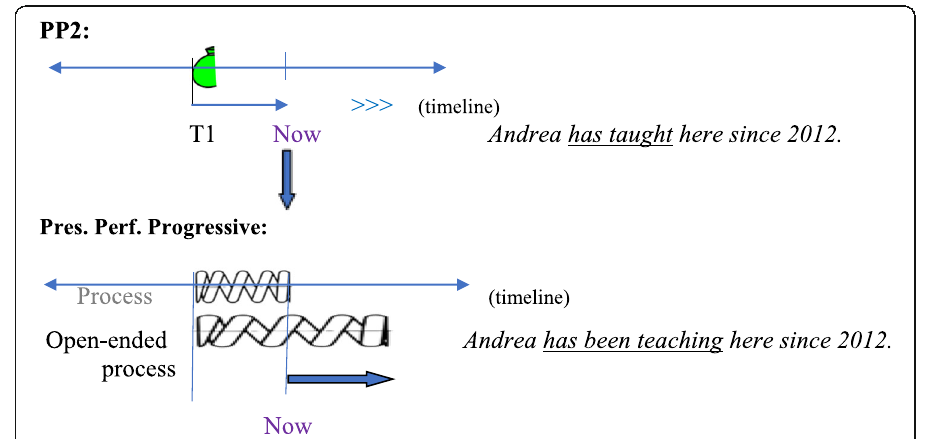
Fig. 10 The temporal characteristics of present perfect progressive, derived from PP2 (present